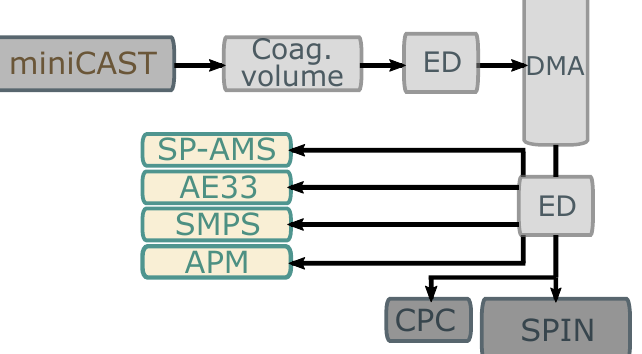
Figure 1. Experimental set-up for this study. DMA: Differential Mobility Analyser, ED: Ejector diluter, SP-AMS: Soot-Particle Aerosol Mass Spectrometer, AE33: Aethalometer, SMPS: Scanning Mobility Particle Sizer, APM: Aerosol Particle Mass Analyser, CPC: Condensation Particle Counter and SPIN; SPectrometer for Ice